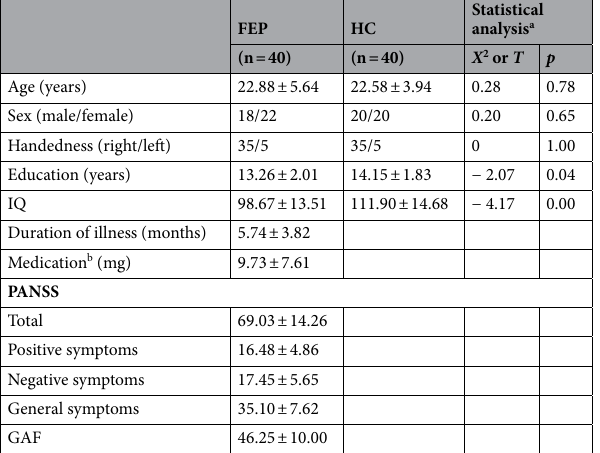
Table 1. Demographic and clinical variables of the subjects. Data are presented as the means ± standard deviations (SD). Abbreviations: FEP first-episode psychosis, HC healthy control, PANSS Positive and Negative Syndrome Scale, GAF Global Assessment of Functioning. a Independent t test or Welch’s t test if the variances were not equal, χ 2 analysis or Fisher’s exact test for categorical data. b Olanzapine-equivalent dose.